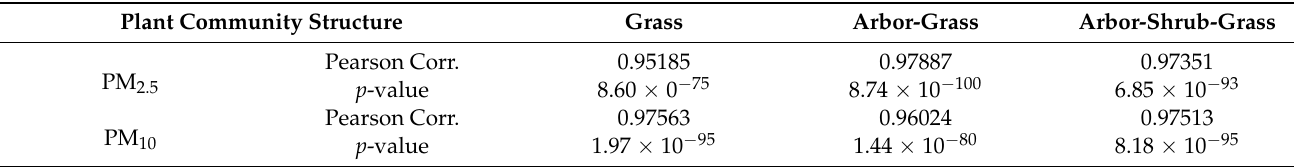
Table 2. Correlation analysis between the observed PM 2.5 and PM 10 concentrations and the background concentrations. Plant Community Structure